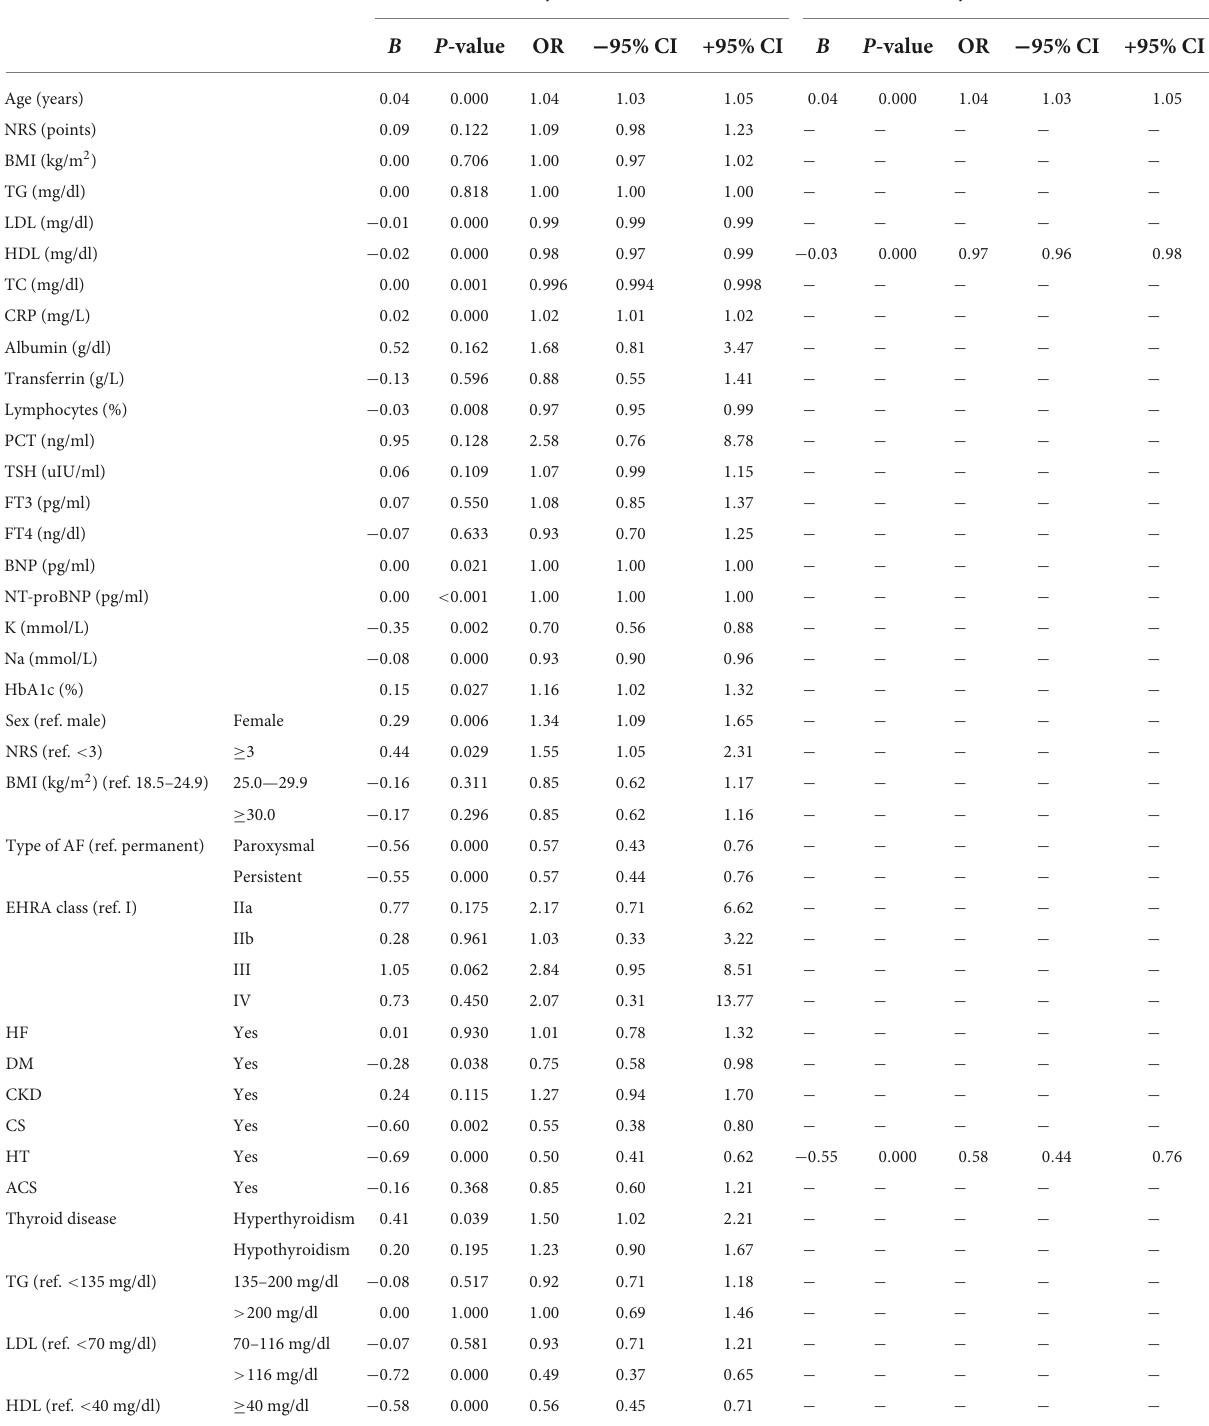
TABLE 6 Effect of selected parameters on length of hospital stay ( < 5 vs. ≥ 5 days) (univariate model and multivariate predictors included in logistic regression analysis). Parameter Unadjusted